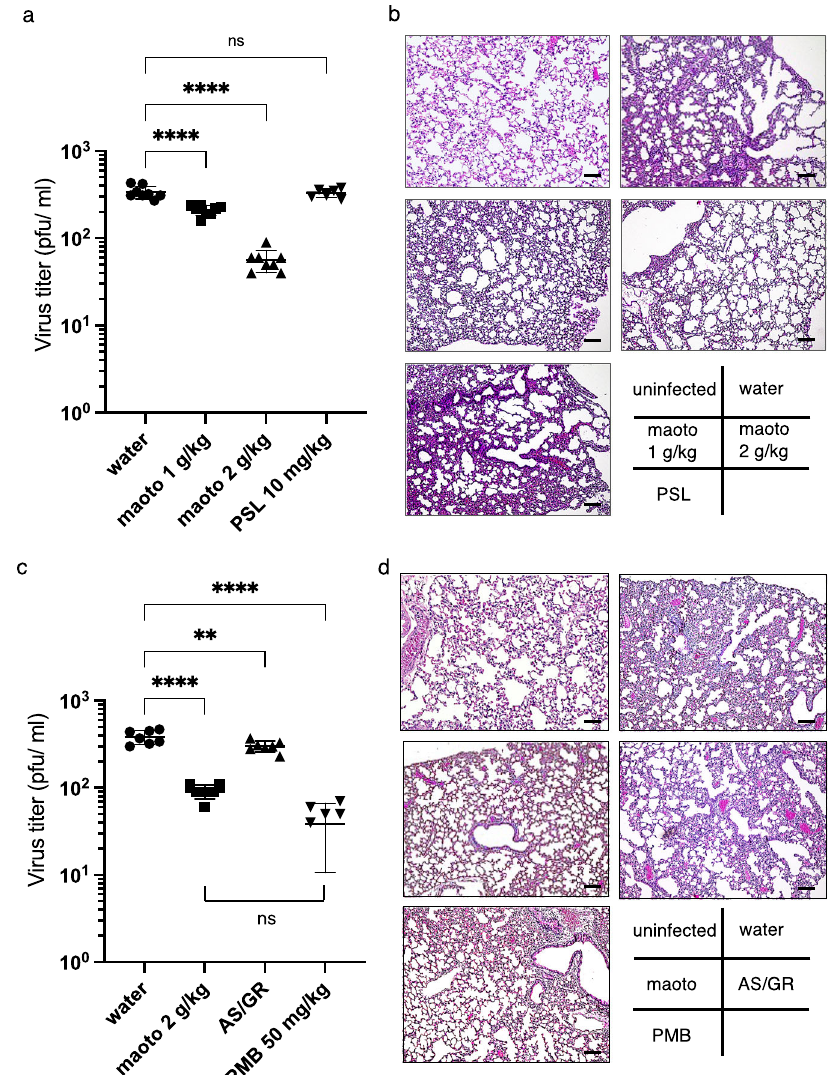
Fig. 6 Reduction of viral load by maoto in mice infected with RSV. a , b Experiment 1. c , d Experiment 2. a Female BALB/c mice were intranasally infected with RSV (1.8 × 10 6 PFU), and then orally administered maoto (1,000 mg/kg or 2,000 mg/kg), water (10 mL/kg), or prednisolone (10 mg/kg) for 5 days. Viral loads in BALF determined by PFU assay. b , d Histopathological fi ndings in the lungs of mice infected with RSV (x100). Sections were stained with haematoxylin and eosin. c Female BALB/c mice were intranasally infected with RSV (1.8 × 10 6 PFU), and then orally administered maoto (2,000 mg/kg), water (10 mL/kg), AS/GR (645 mg/kg, 194 mg/kg, respectively), or PMB (50 mg/kg) for 5 days. Viral loads in BALF determined by PFU assay. a , c show individual values and mean ± error bars SD (a: n = 8, c: n = 7). One-way ANOVA followed by Dunnett ’ s post-test. ** P < 0.01, **** P < 0.0001 and ns; not signi fi cant. PSL: prednisolone. AS: Armeniacae Semen, GR: Glycyrrhize Radix, PMB, palivizumab. b , d Scale bars indicate 50 µ